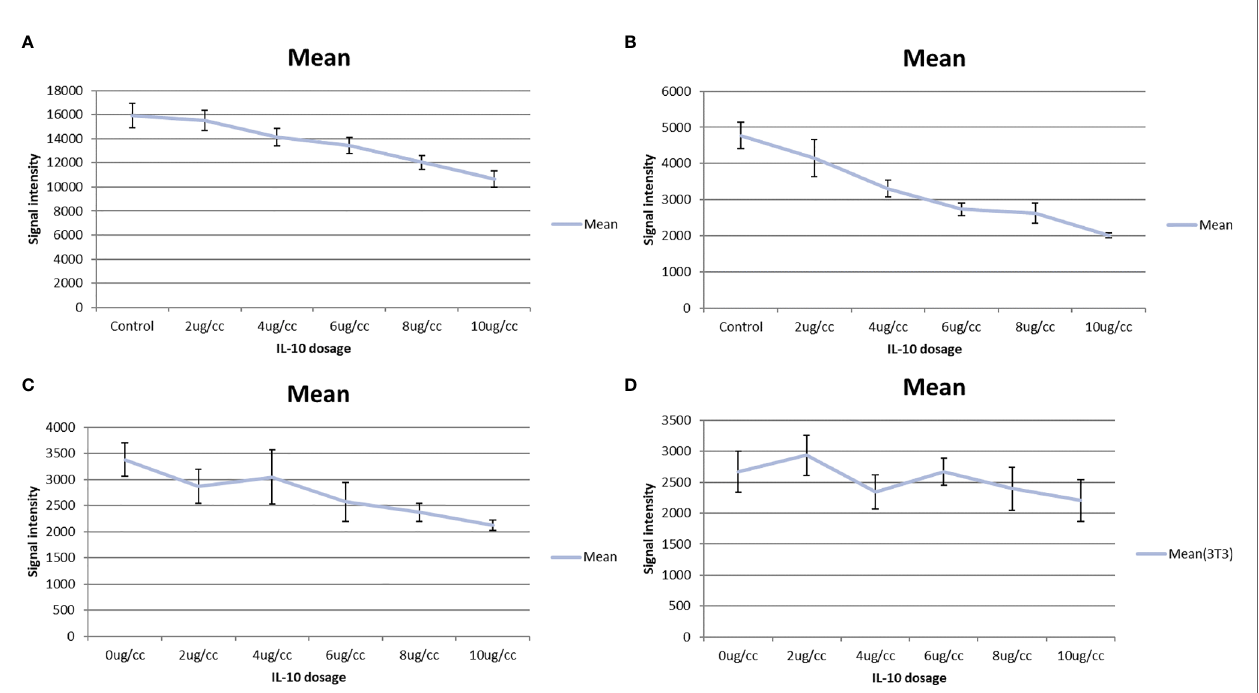
FIGURE 5 | IL-10 in vitro toxicity on cell lines shown by alamar blue cell titer assay. (A) Alamar blue cell titer results of 4T1 cells treated with varies dosages of IL-10. A dose-response graph is noted and IL-10 has direct in vitro toxicity on 4T1 cells. (standard error is used in the graph). (B) Alamar blue cell titer results of NXS2 cells treated with varies dosages of IL-10. A dose-response graph is noted and IL-10 has direct in vitro toxicity on NXS2 cells. (standard error is used in the graph). (C) Alamar blue cell titer results of RAW macrophage cells treated with varies dosages of IL-10. A dose-response graph is noted and IL-10 has direct in vitro toxicity on RAW macrophage cells.(Positive control) (standard error is used in the graph). (D) Alamar blue cell titer results of NIH 3T3 fi broblast cells treated with varies dosages of IL-10. No dose-response graph is noted and IL-10 has no in vitro toxicity on NIH 3T3 fi broblast cells. (Negative control) (standard error is used in the